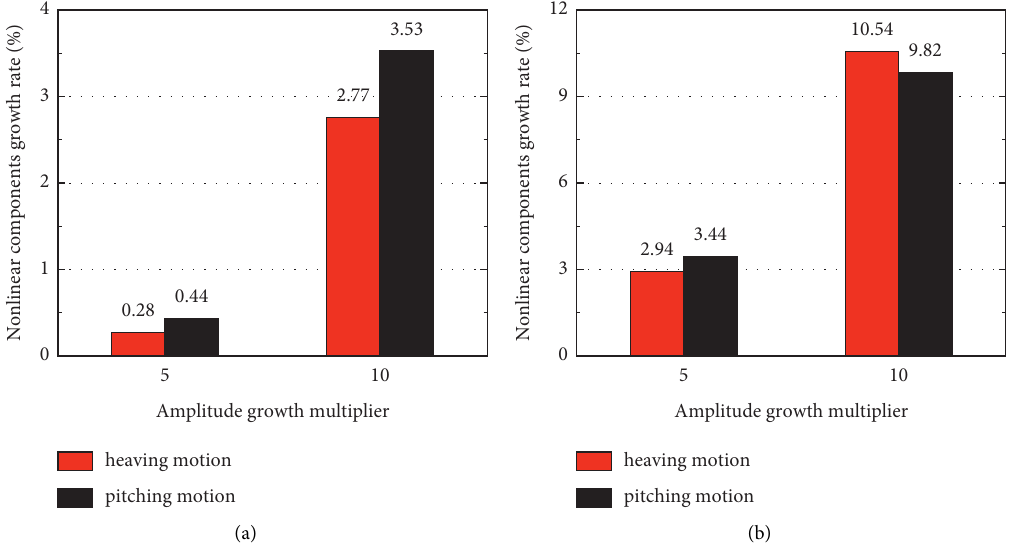
Figure 15: Nonlinear components growth rate under multiplying increasing amplitude. (a) Aerodynamic lift. (b) Aerodynamic